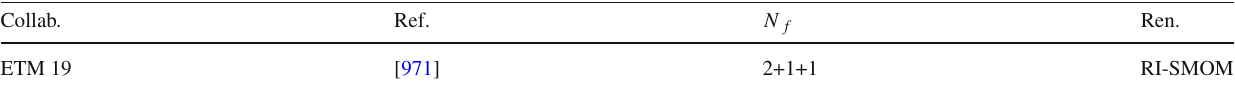
Table 188 Control of excited state contamination in determinations of g q the range of source-sink separations τ (in fermi) at each value of the bare coupling Collab.